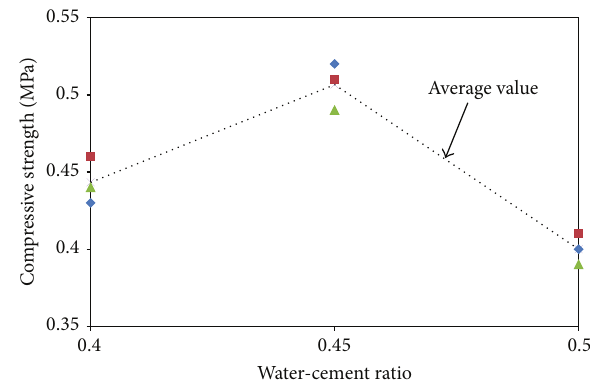
Figure 4: The influence of fly ash activator content on the compres- sive strength of FC. Figure 5: The influence of the WC ratio on the compressive strength